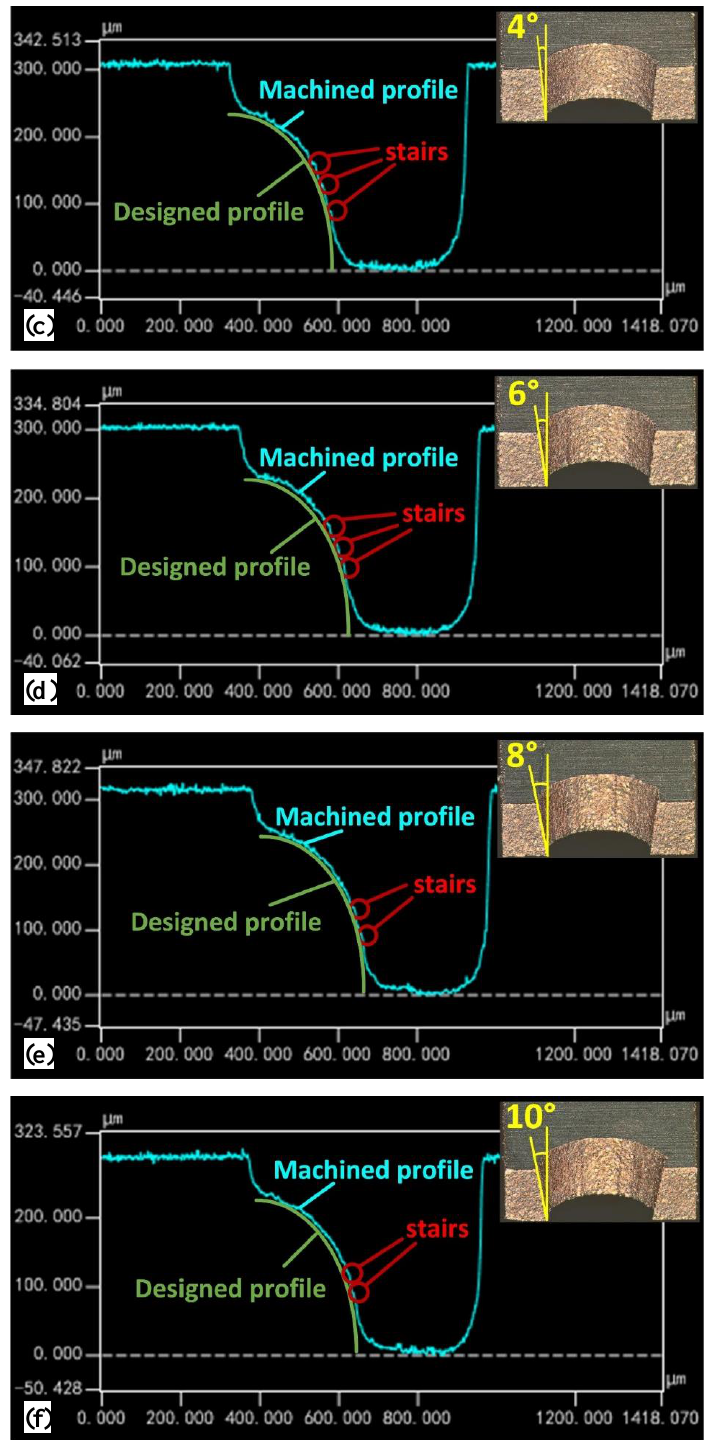
Figure 4. Micro-EDM results of FQ-microelectrode with different tapers observed by laser scanning confocal microscopy: ( a ) 0 ◦ ; ( b ) 2 ◦ ; ( c ) 4 ◦ ; ( d ) 6 ◦ ; ( e ) 8 ◦ ; ( f ) 10 ◦